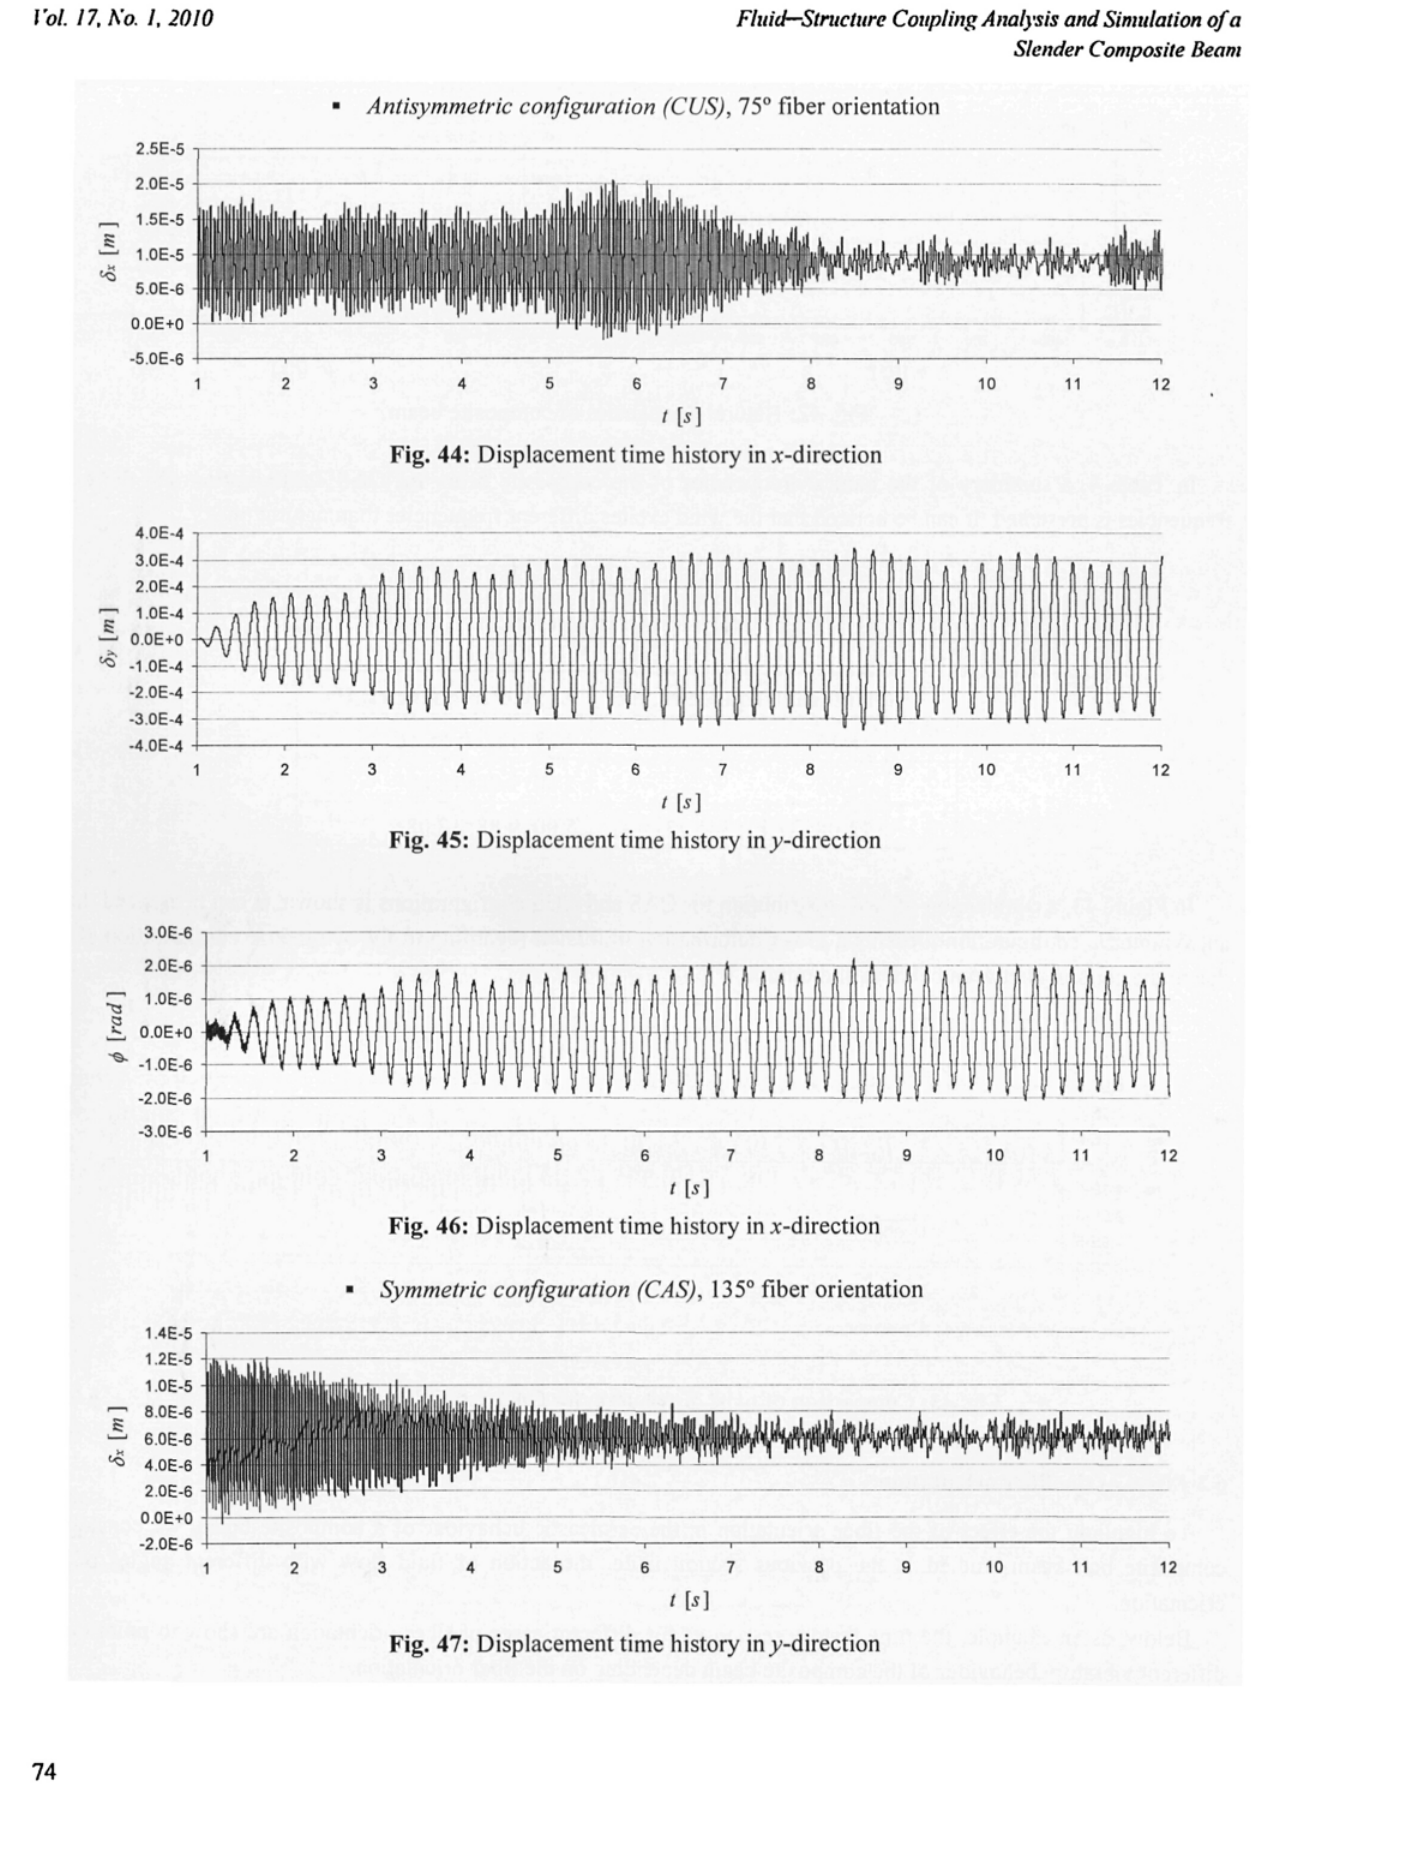
Fig. 44: Displacement time history in ^-direction